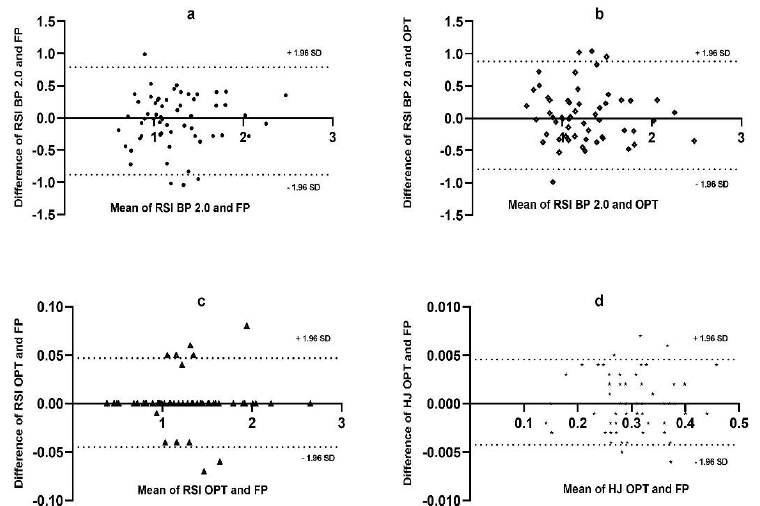
Figure 3. Agreement of the results of the Bland–Altman analysis. The x -axis represents the values of the means, and the y -axis represents the differences between the means. The criteria for all analyses were (+1.96 SD) as the upper range and ( − 1.96 SD) as the lower range. ( a ) Bland–Altman analysis RSI between PB2.0 and FP; ( b ) Bland–Altman analysis RSI between PB2.0 and OPT; ( c ) Bland–Altman analysis RSI between FP and OPT; ( d ) Bland – Altman analysis HJ between PB2.0 and OPT.